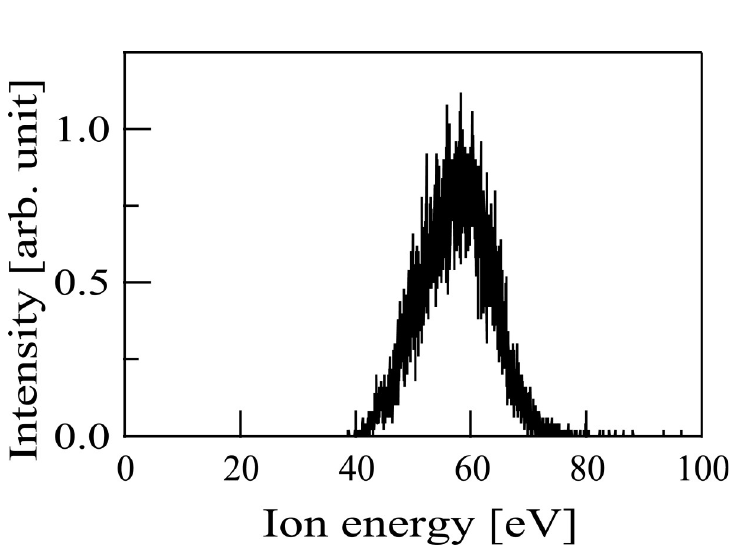
Fig 6. Energy distribution of the Sn + ion beams produced when tetramethyltin was used as the source material.